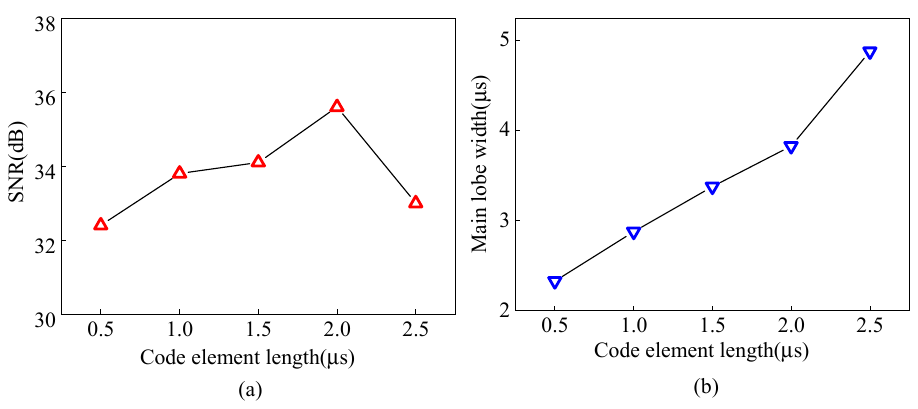
Figure 26. Curves of ( a ) SNR ( b ) main lobe width of defected waves from angled SV wave EMAT after pulse compression with different code length.